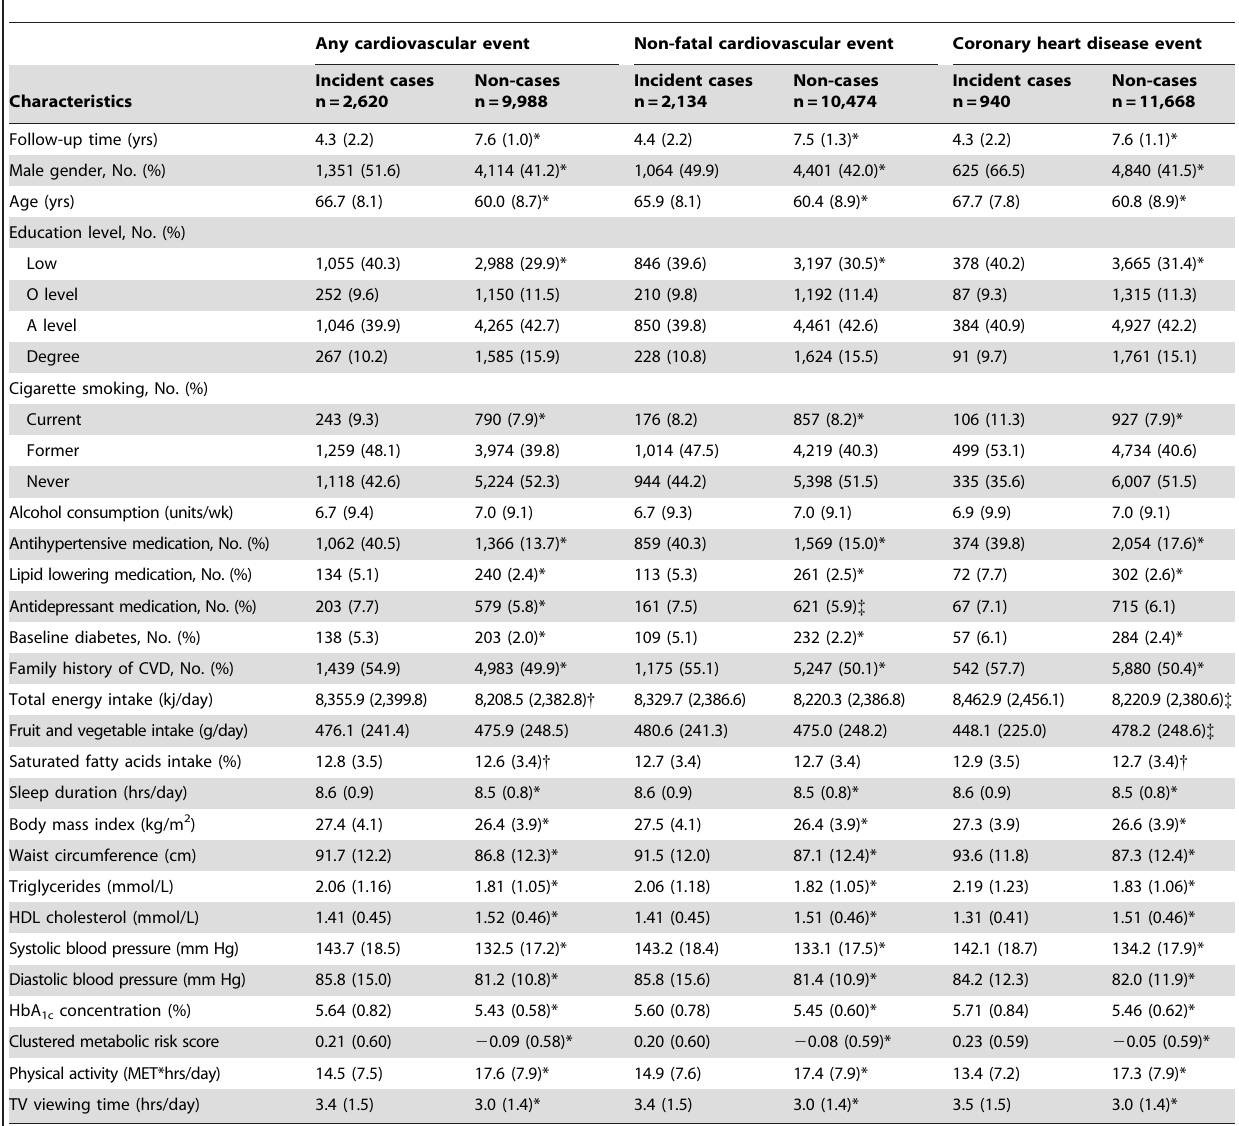
Table 1. Descriptive characteristics (mean (SD) or No. (%)) at baseline between incident cardiovascular event cases and non-cases in 12,608 men and women in EPIC Norfolk,